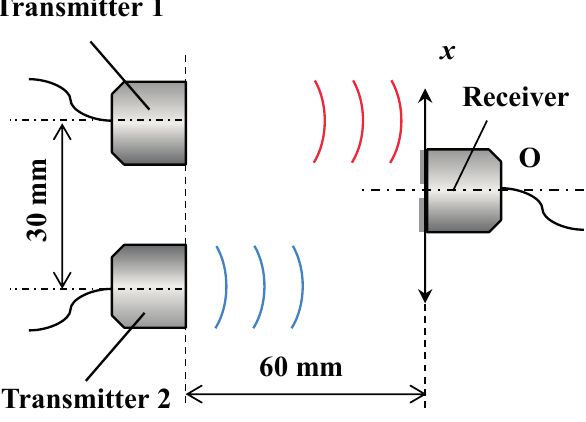
Figure 3. Experimental setup for measuring relative lateral displacement sensing using two transmitters.